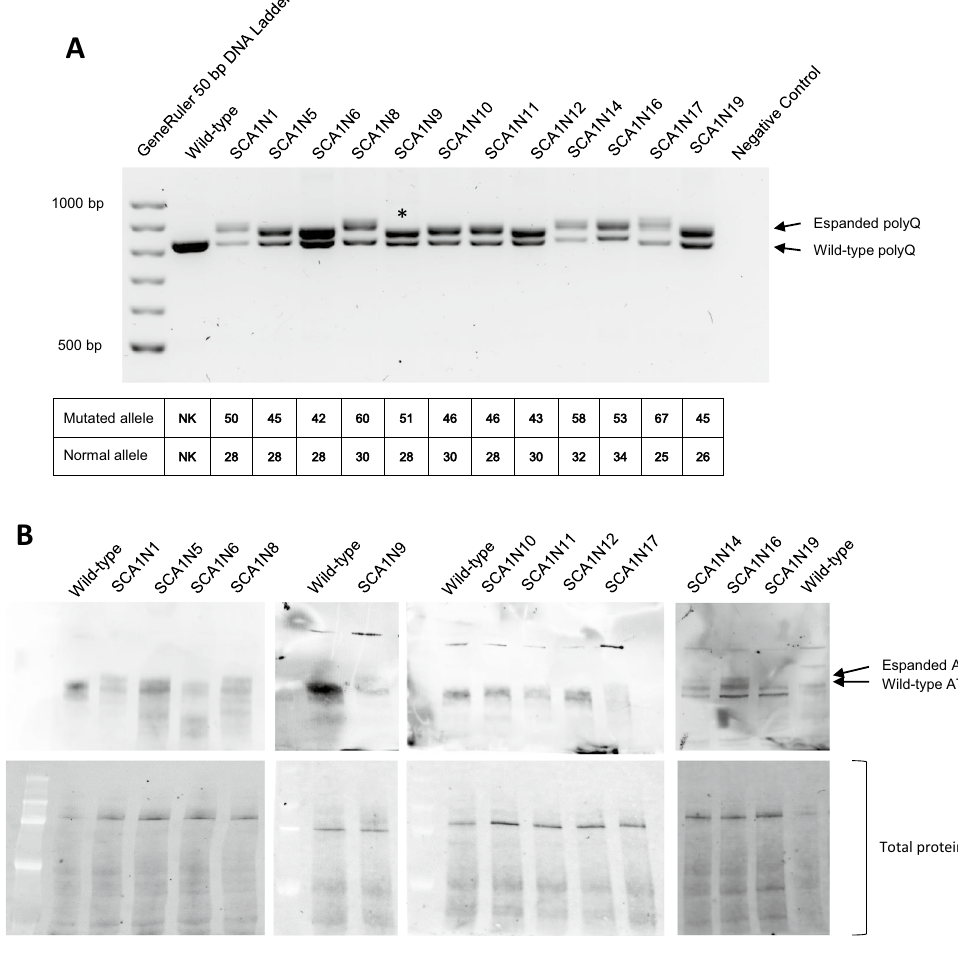
Figure 2. Characterization of SCA1 fibroblasts. ( A ) Amplification by PCR of the ATXN1 exon 8 containing the polyQ tract, using the genomic DNA extracted from the five SCA1 patients’ fibroblasts as template. The negative control consists of a PCR reaction in the absence of template DNA, replaced by water. In the table are reported the triplet numbers of the two alleles, mutated and normal, obtained from the patients’ genetic analysis. ( B ) The upper membranes are related to the ATXN1 expression in SCA1 fibroblasts, using 12NQ antiserum as anti-ATXN1 antibody. The bottom membranes are related to the total amount of proteins for each sample. * Discrepancy between the data we obtained, and the result of the genetic analysis carried out on the patient SCA1N9, not due to the methods we used to verify the presence of the two alleles. DNA ladder: